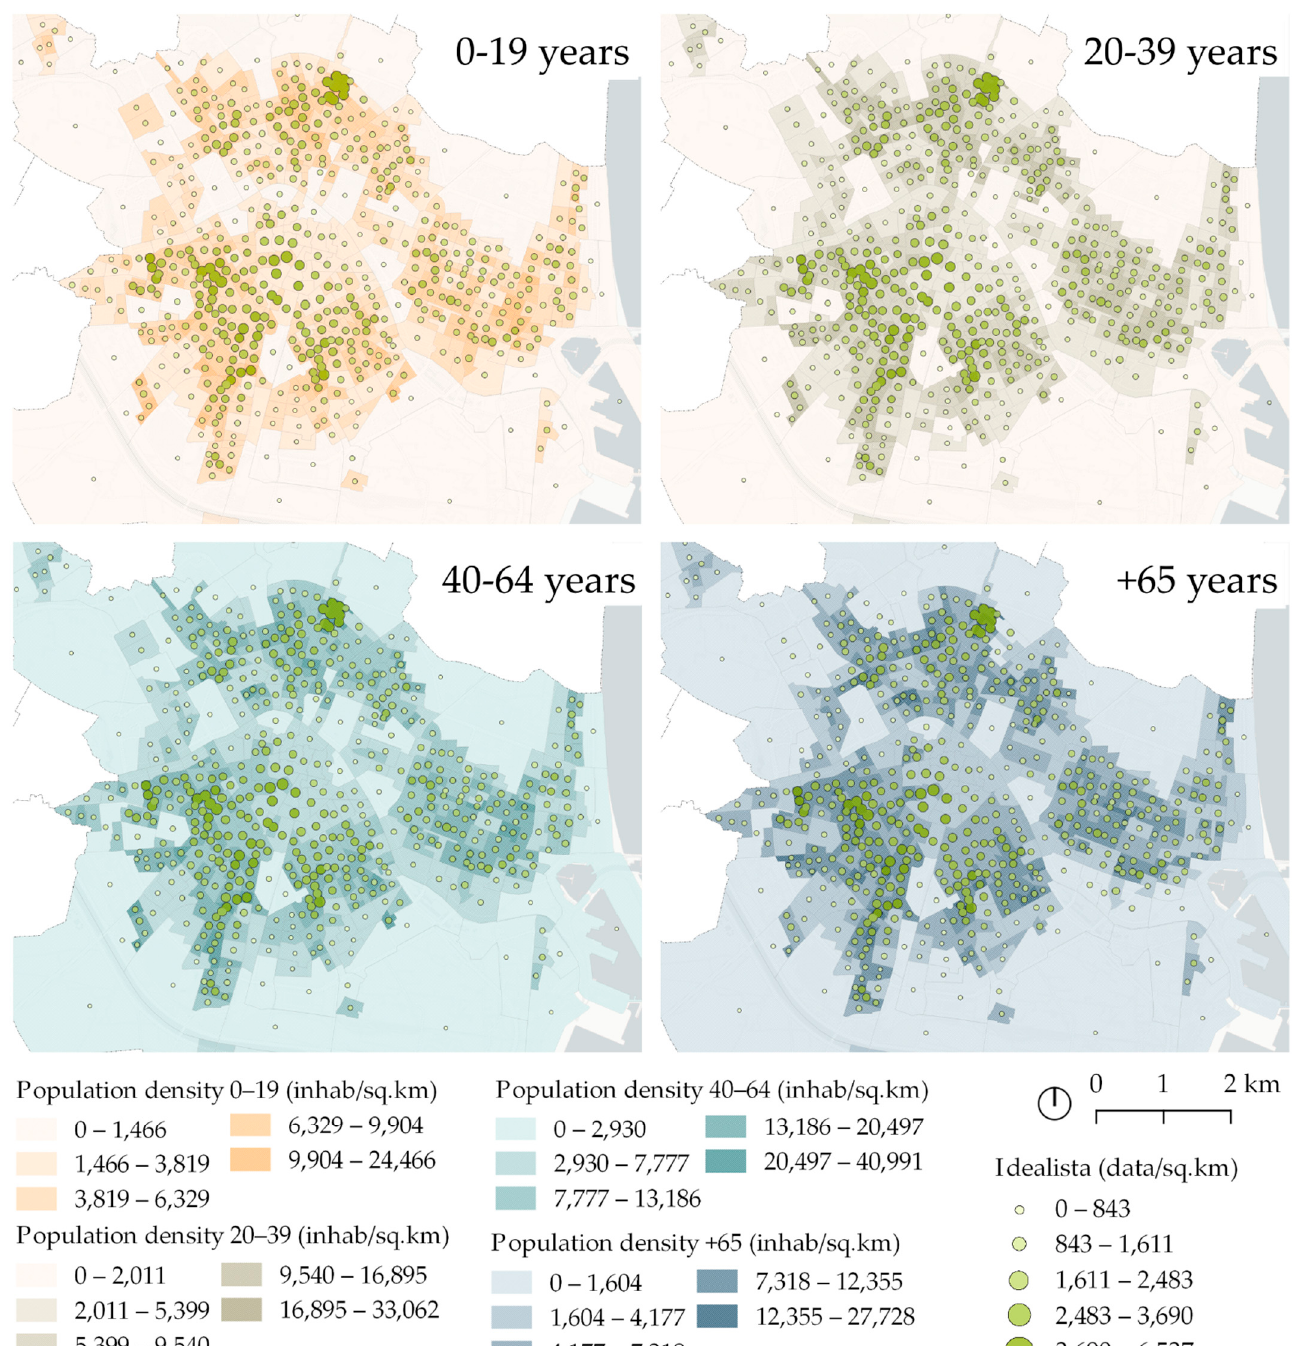
Figure 9. Population density per age group and Idealista data density.